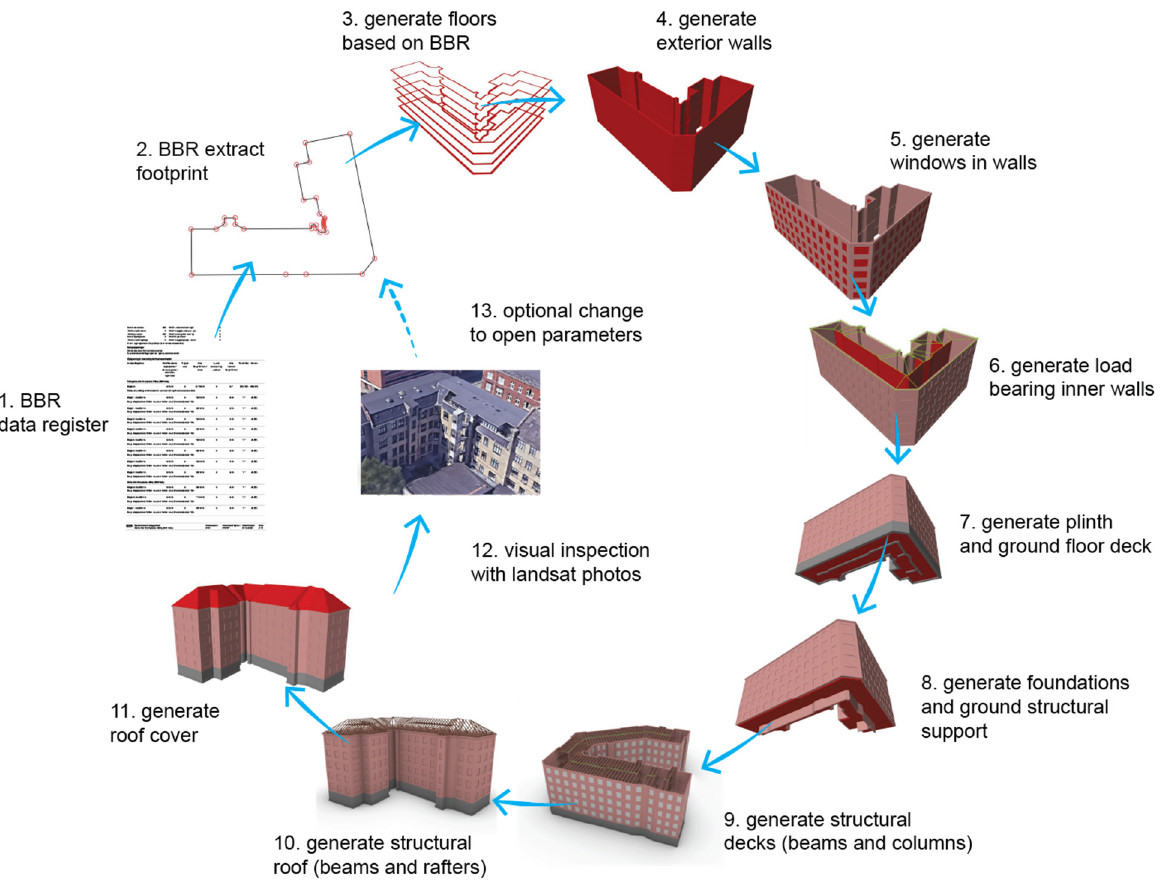
Figure 1. Step by step guide to the auto generation of the parametric BIM model with assignment of specific building components based on typical historical building practice.